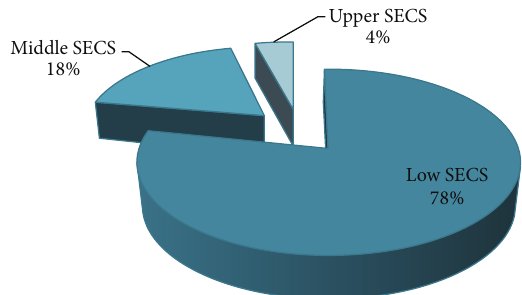
Figure 1: Family socioeconomic class (SECS) distribution of